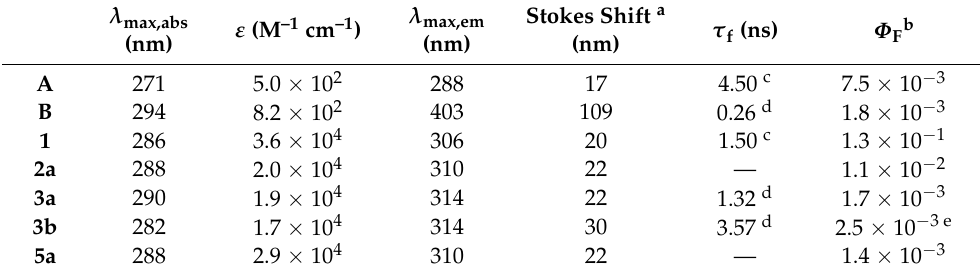
Table 4. Photophysical properties of the studied compounds in CH 2 Cl 2 at 293 K.